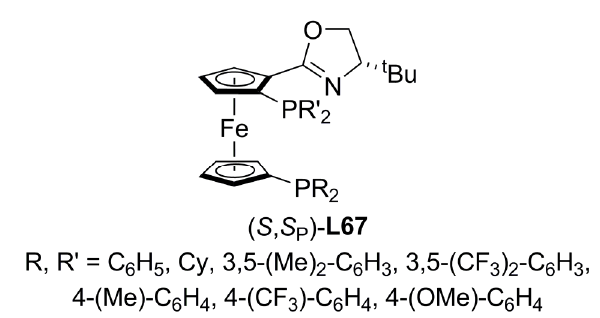
Figure 24. Ferrocenyloxazoline diphosphines.